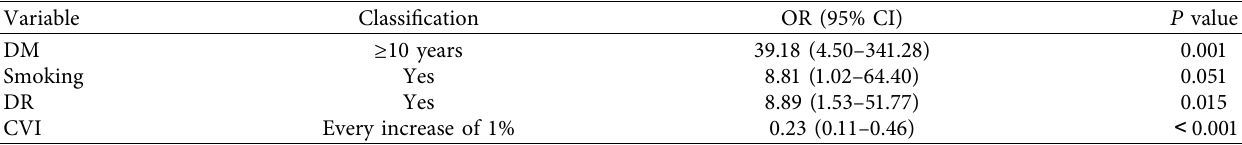
Table 2: Logistic regression of risk factors for